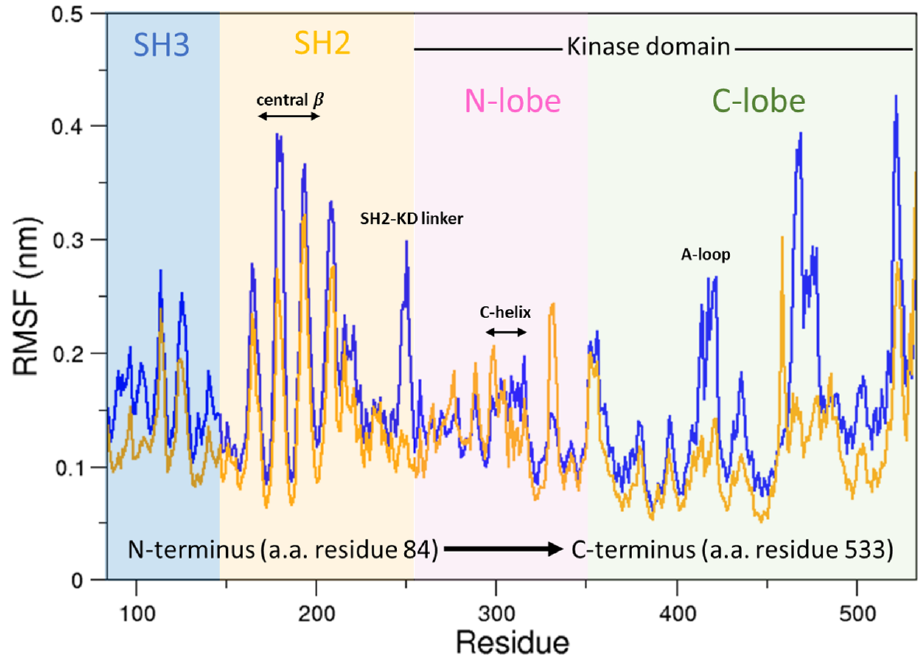
Figure 10. RMSFs of the c-Src unbound compared to c-Src–imatinib. In orange is the RMSF of c-Src unbound; in blue is the RMSF of c-Src bound to imatinib.